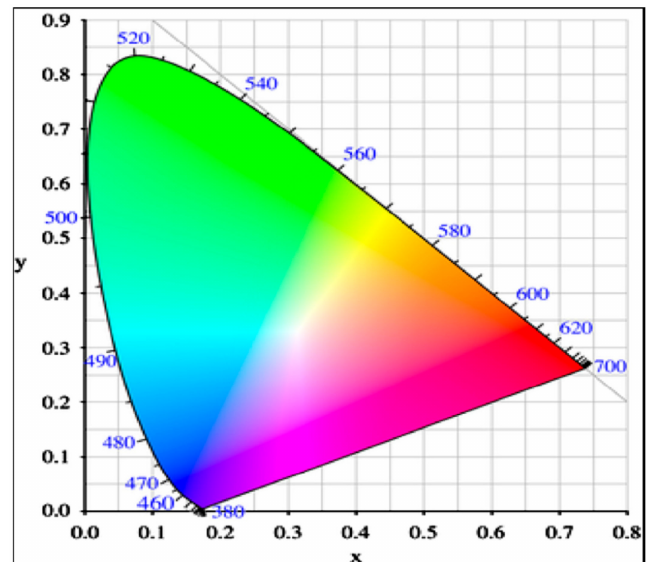
Figure 2. CIE1931 color space chromaticity diagram